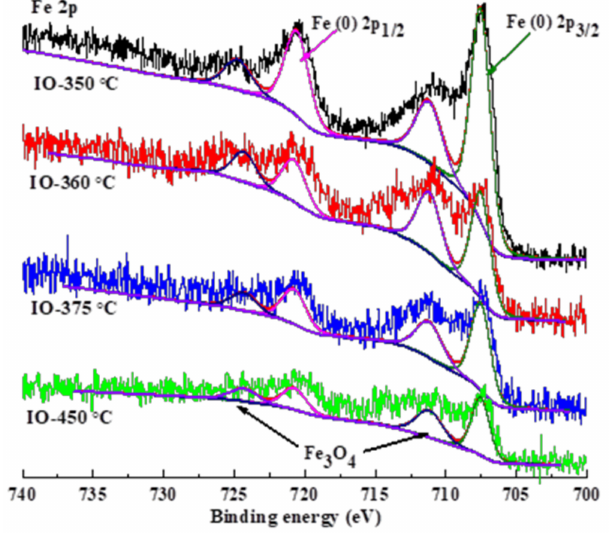
Figure 3. The elaboration results of Fe 2p of the fresh IO-t ◦ C